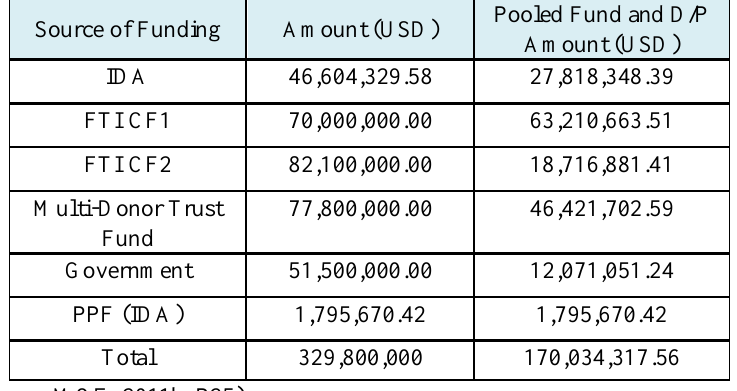
Table 6-2: Source of Funding for GEQIP (Project Total)